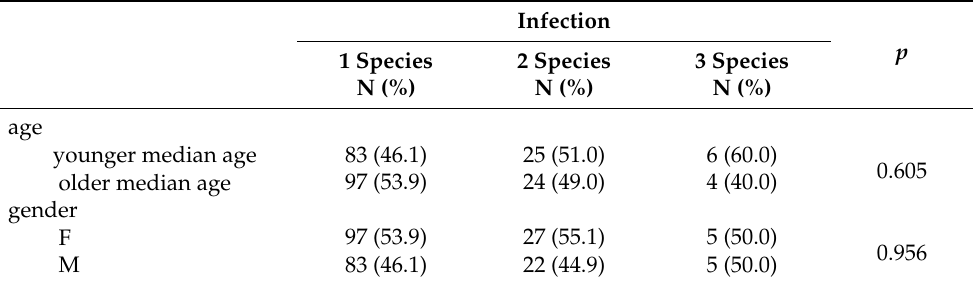
Table 4. Distribution of number of species stratified for age of the patients (younger vs. older median age) and gender.